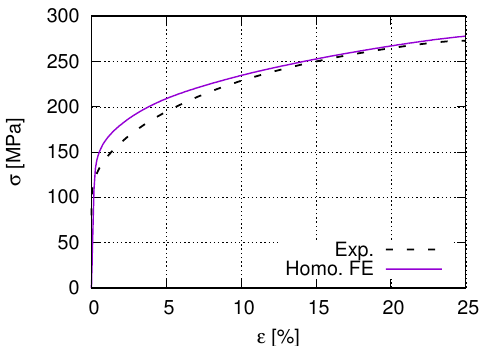
ε curves from FE prediction for −